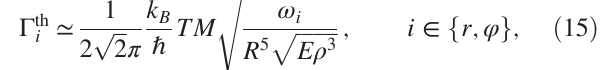
14 . 24 . The relation between the total laser =P b r ¼ ; ω φ Þ ¼ 2 π × r